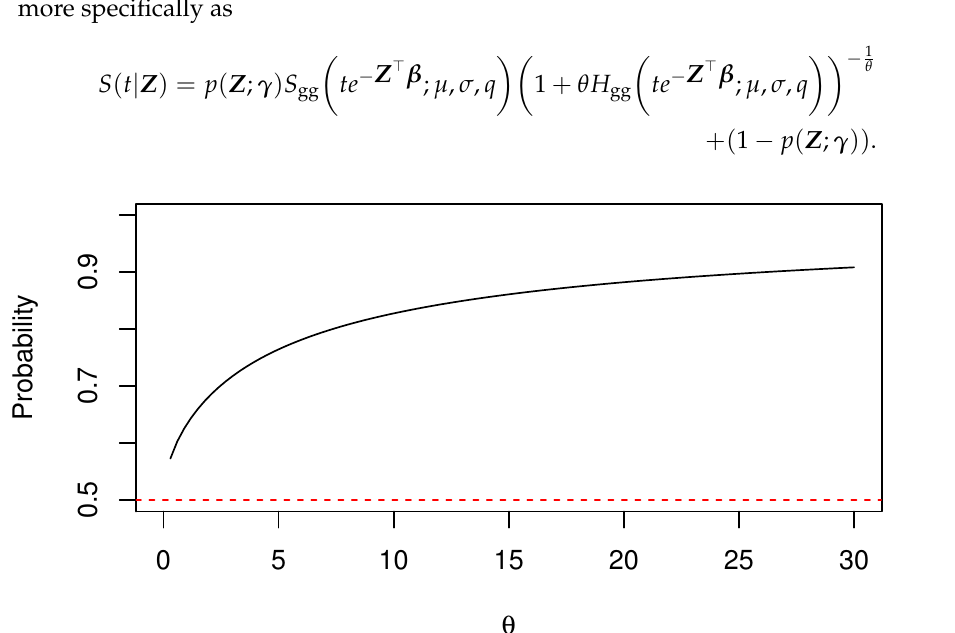
Figure 1. Graph of probability P ( Y < 1 ) for Y ∼ Gamma ( θ ,1/ θ )